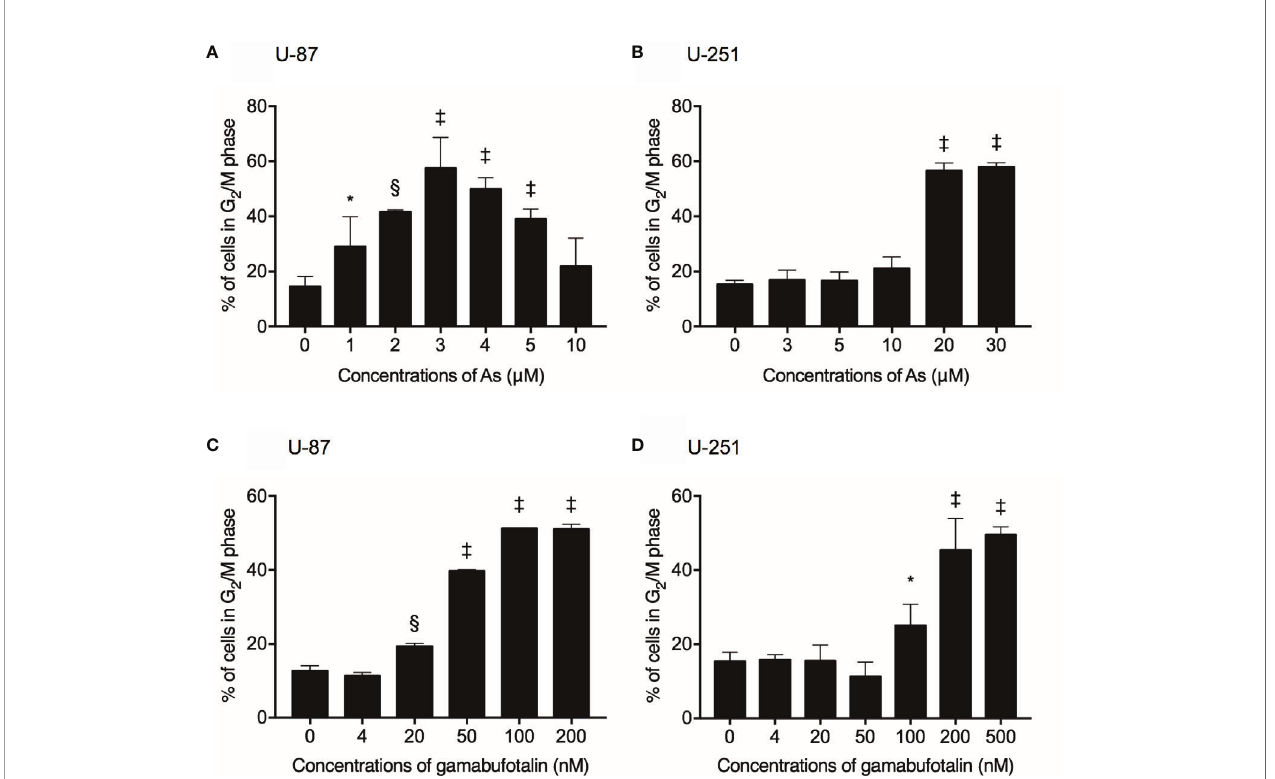
FIGURE 2 | Respective G 2 /M arrest-inducing activity of As III and gamabufotalin in U-87 and U-251 ells. Following treatment for 48 h with various concentrations of As III (1, 2, 3, 4, 5, 10, 20, and 30 µM) alone (A, B) , gamabufotalin (4, 20, 50, 100, 200, and 500 nM) alone (C, D) , cell cycle pro fi ling was performed by FACSCanto fl ow cytometer as described under Materials and Methods . A total of 10,000 events were acquired, and FACSDiva ™ software and ModFit LT ™ v3.0 were used to calculate the number of cells at G 2 /M phase fraction. Results are shown as the means ± SD (n ≥ 3). Signi fi cant difference between control and treatment groups are shown (*p < 0.05; § p < 0.001; ‡ p < 0.0001 vs. control). As, As III